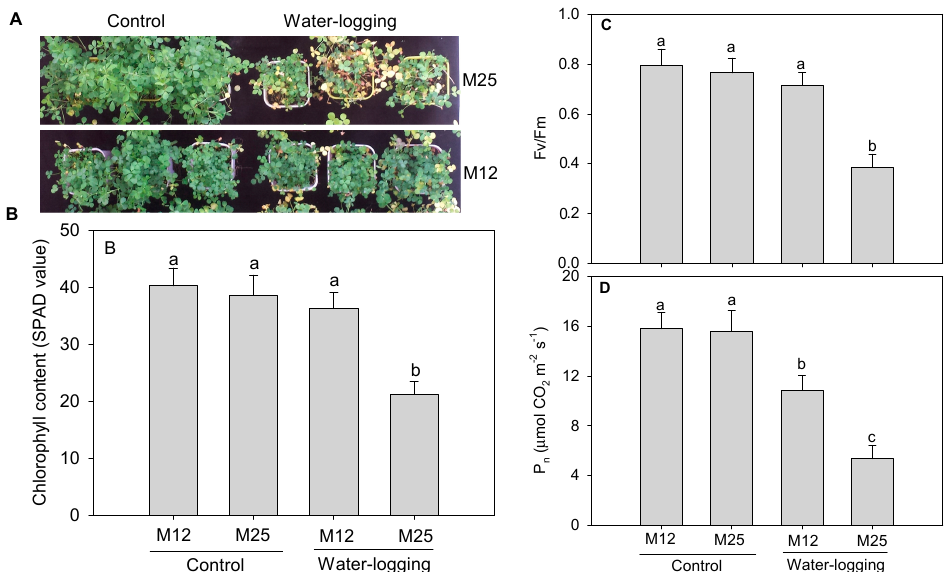
Figure 1. Effect of waterlogging on the phenotypic trait ( A ), leaf chlorophyll content ( B ), maximum quantum yield of photosystem II efficiency (Fv/Fm, ( C ) and net photosynthetic rate (P n ) ( D ) in two alfalfa cultivars with contrasting waterlogging tolerance (M12: tolerant; M25, sensitive). Vertical bars on the top indicate standard deviation, and bars with the same letter indicate no significant difference at p < 0.05 for the comparison of different treatments (Duncan’s multiple range test).